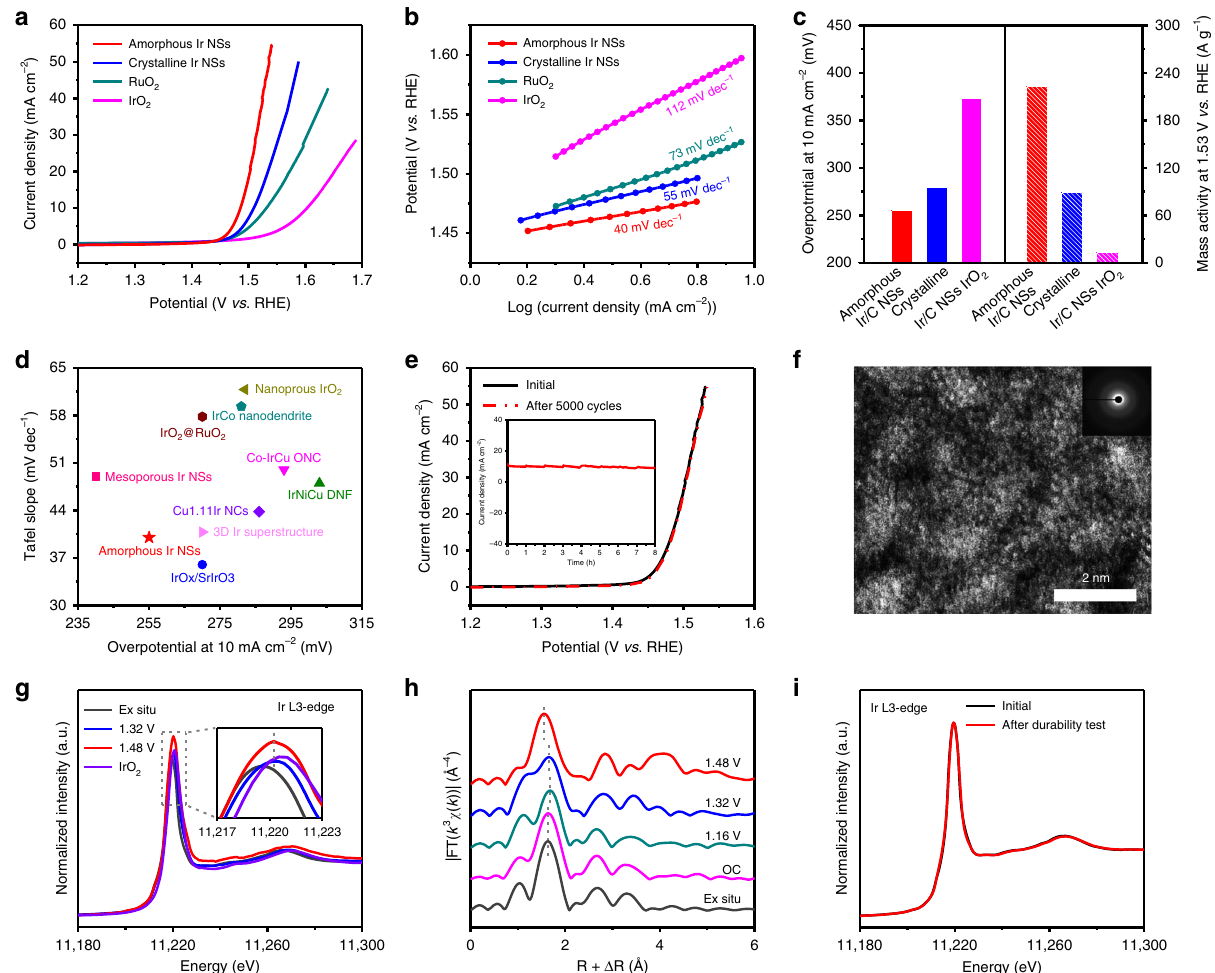
Fig. 4 Electrochemical OER performance and operando X-ray absorption spectroscopy of amorphous Ir NSs. a Polarization curves of amorphous Ir NSs, crystalline Ir NSs, commercial RuO 2 and IrO 2 catalysts, respectively. b Corresponding Tafel plots of amorphous Ir NSs, crystalline Ir NSs, commercial RuO 2 and IrO 2 catalysts, respectively. c Overpotentials at 10 mA cm − 2 (left axis) and mass activity at 1.53 V (vs. RHE) (right axis) of amorphous Ir NSs, crystalline Ir NSs, and commercial IrO 2 catalyst, respectively. d Comparison with different representative catalysts under acidic media. e Polarization curves of amorphous Ir NSs before and after 5000 cycles. The inset in e shows chronoamperometry measurement of the amorphous Ir NSs at an overpotential of 255 mV for a 8-h test. Note: All the measurements were performed in O 2 -saturated 0.1 M HClO 4 solution. f Atomic resolution HAADF-STEM image of the amorphous Ir NSs after durability test. The inset in f shows the corresponding SAED pattern. g , h In situ XAFS spectra change of the Ir L 3 -edge. i